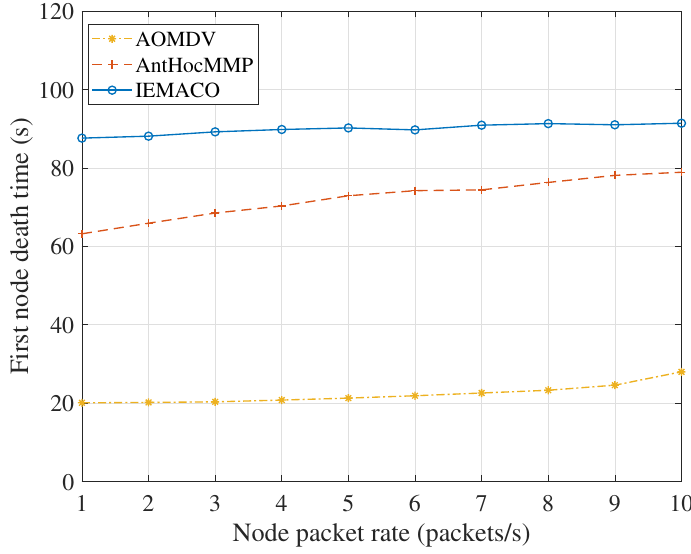
Figure 10. First node death time versus node packet